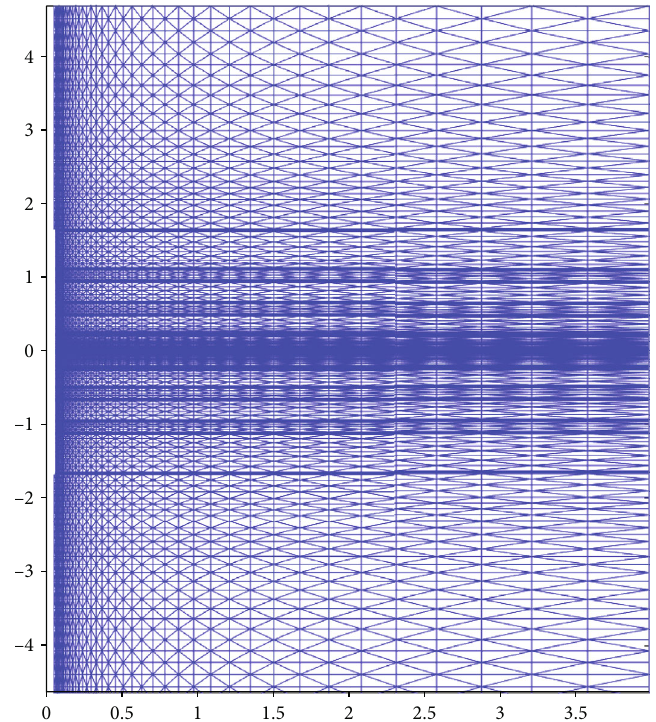
Figure 2: 2D grid of the stratigraphic model.